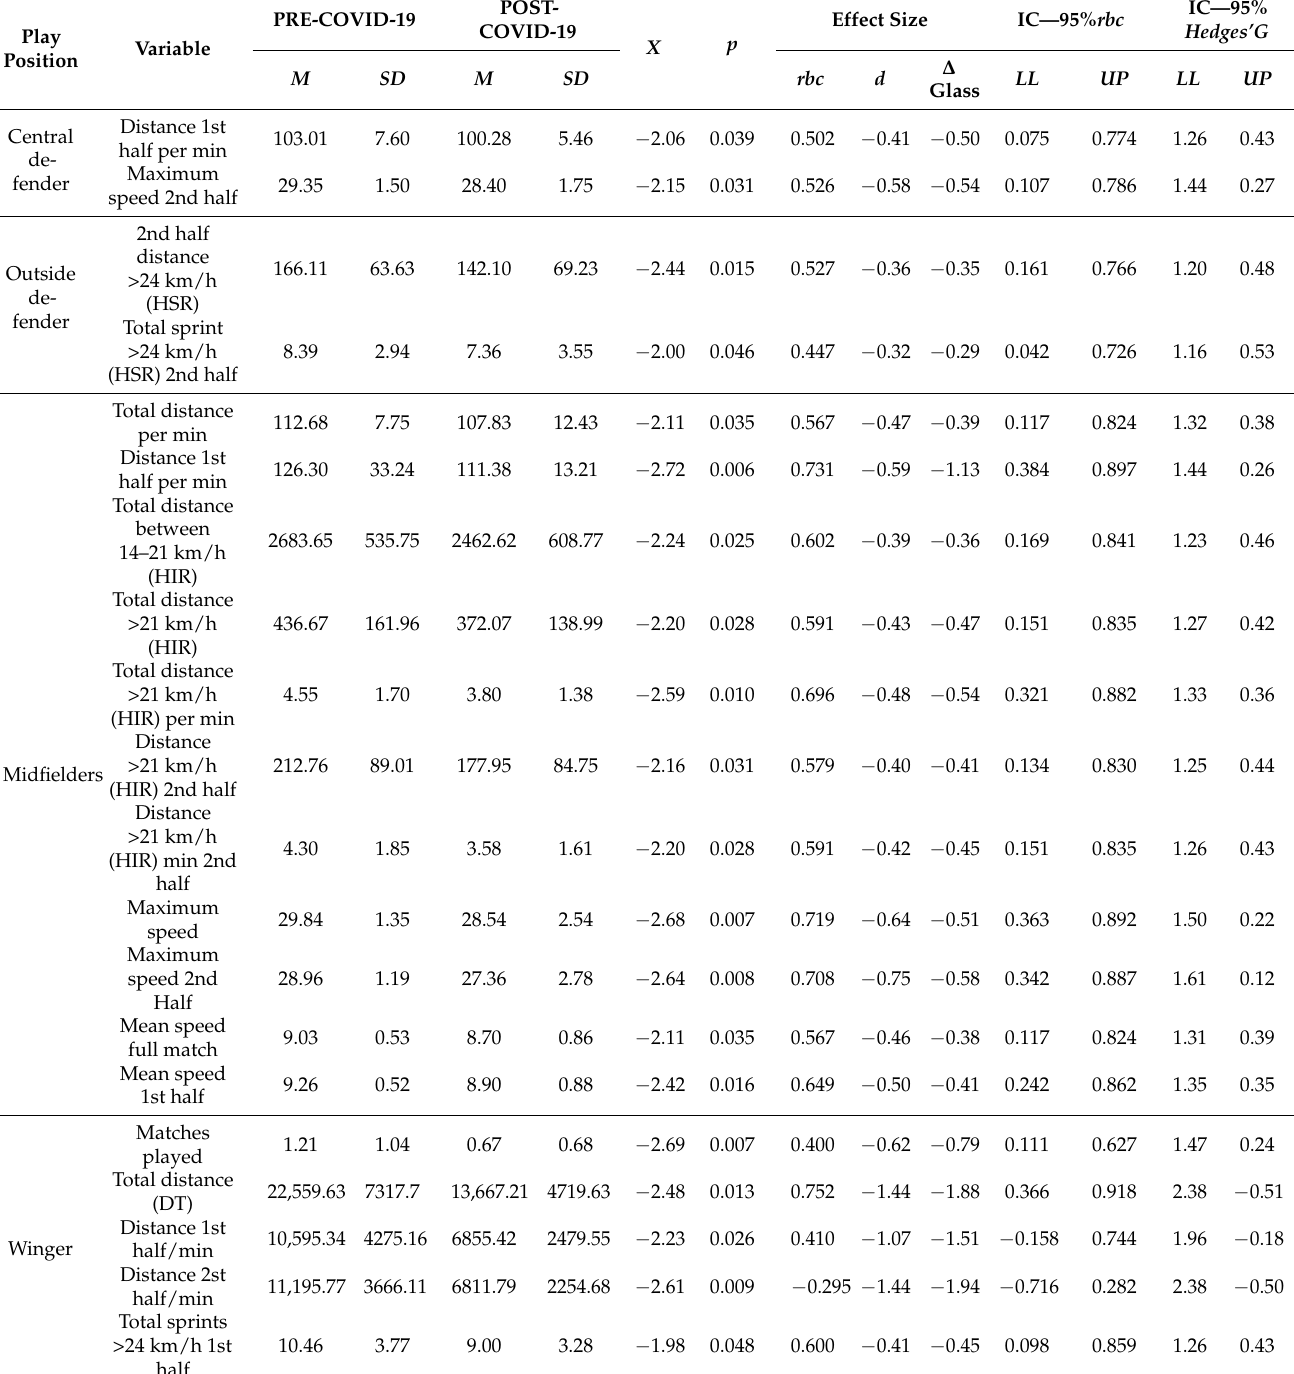
Table 4. Analysis by play position of all players together, not weighted by the number of matches before and after the isolation